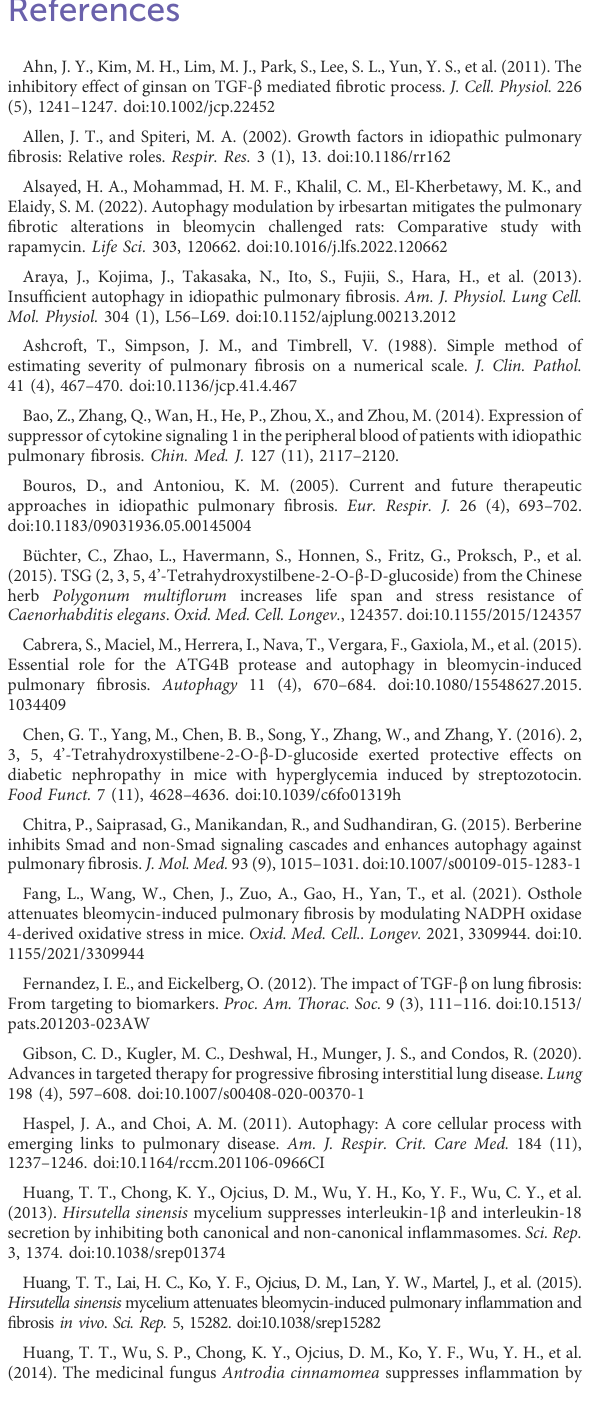
and JNK proteins. Data are represented as the mean ± SEM of three independent experiments. # p < 0.05 compared with untreated group. * p < 0.05 compared with TGF- β 1-treated group. SUPPLEMENTARY FIGURE S3 Effect of THSG on autophagy in A549 cells treated with TGF- β 1. (A) The cells were starved for 24 h, before treatment with various concentrations(50and100 μ g/ml)ofTHSGfor2 h,andthenincubated